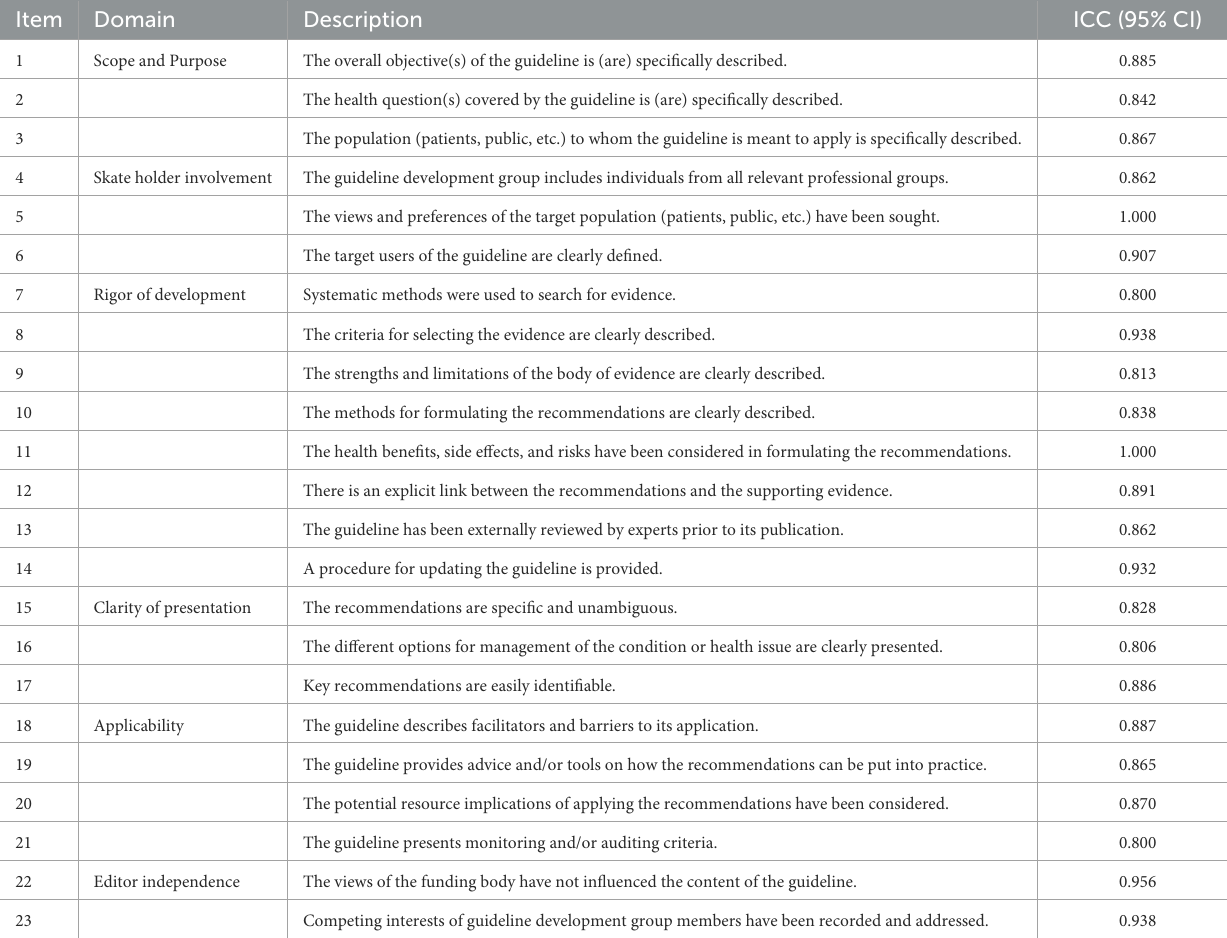
TABLE 3 The intra-group correlation coefficients of the